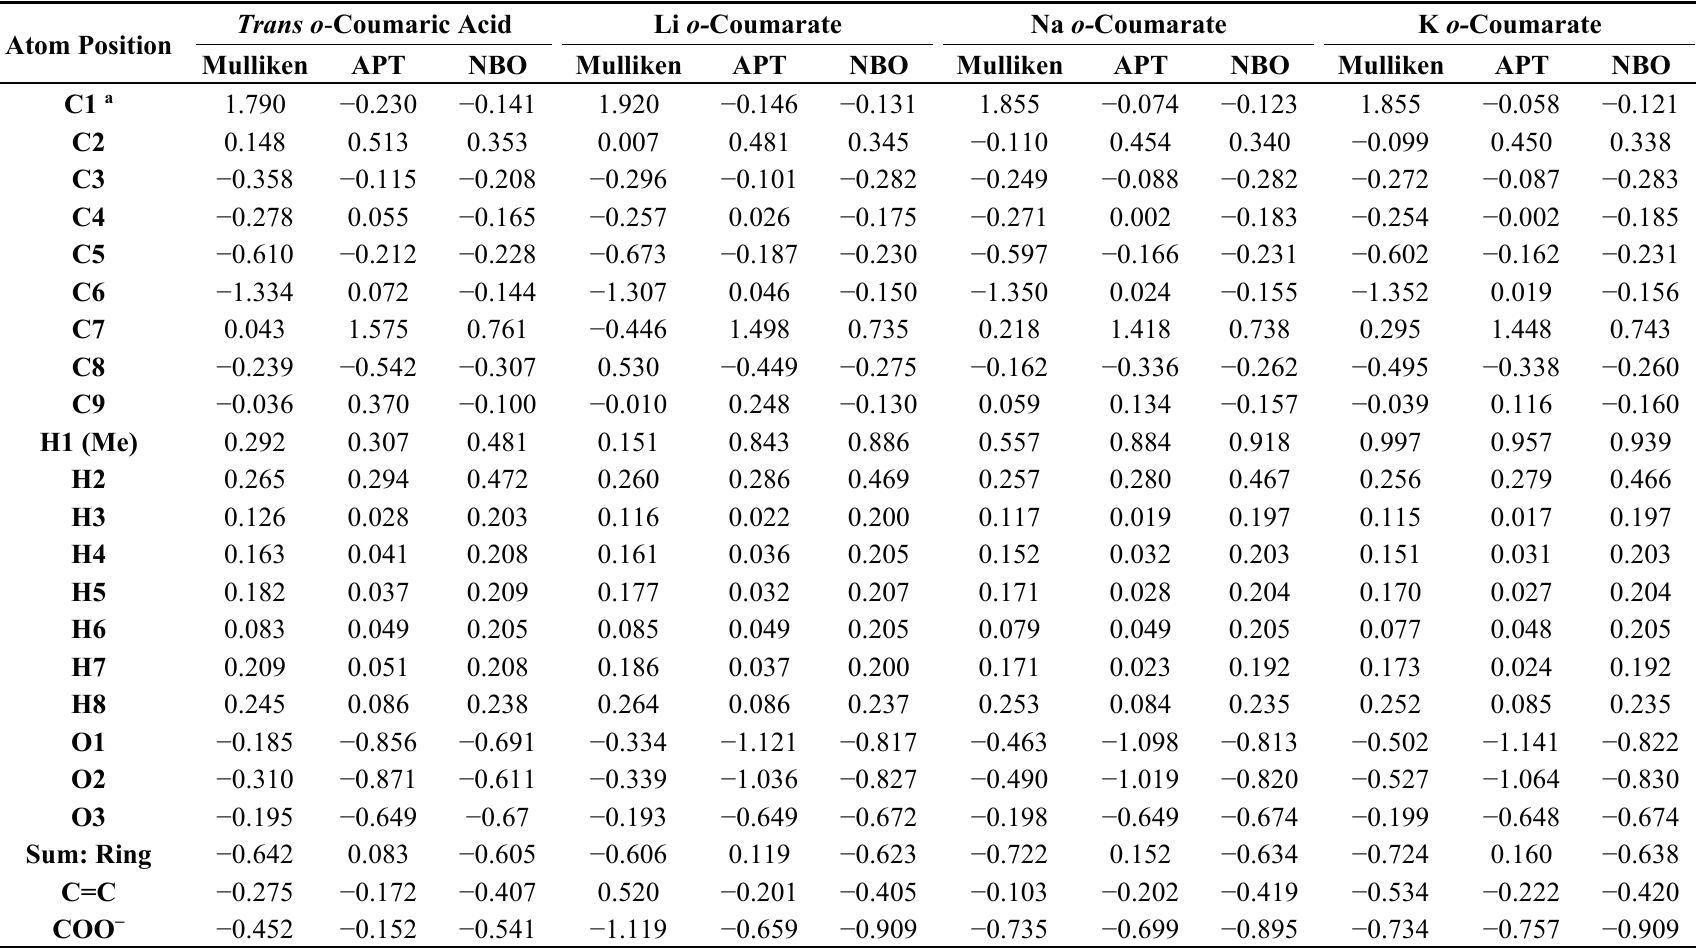
Table 3. The atomic charges for trans o-coumaric acid as well as for lithium, sodium and potassium o-coumarates calculated in the B3LYP/6-311++G6**